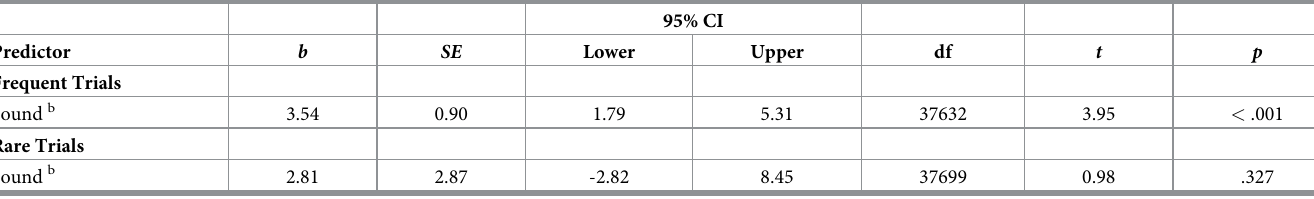
Table 2. Regressions for reaction times for frequent and rare trials predicted by sound condition.